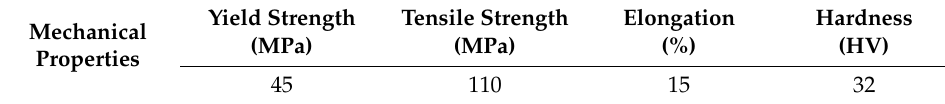
Table 3. Mechanical properties of the EN AW 5005 aluminum alloy